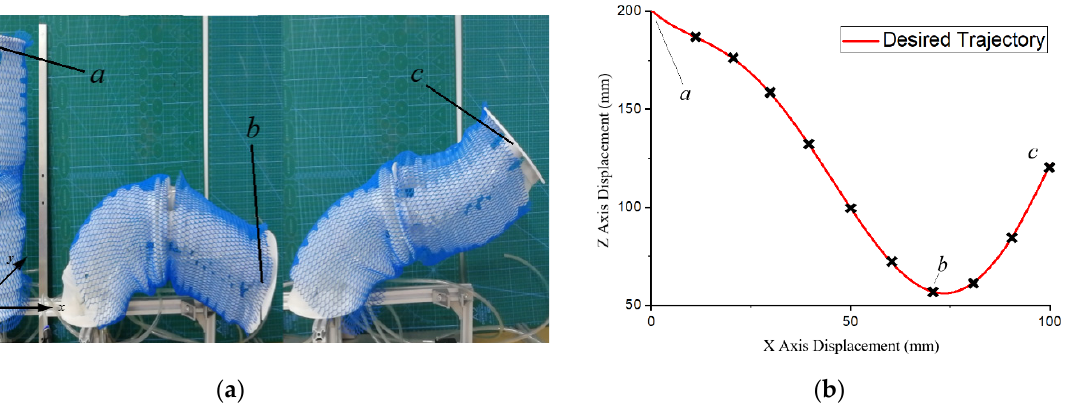
Figure 10. An experiment of the soft manipulator movement: ( a ) point a represents the initial position of the manipulator, b represents the manipulator movement toward the lowest position, and c represents the most complex position of the manipulator under stress; ( b ) preset trajectory of the soft manipulator motion in the x–z plane.